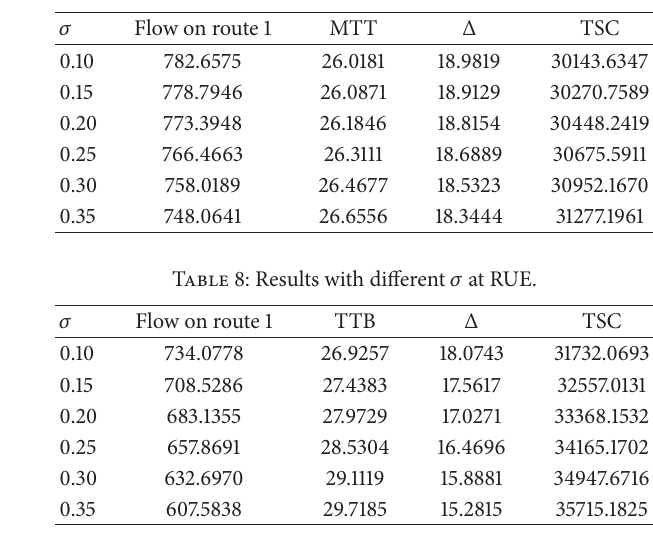
Table 7: Results with different 𝜎 at UE.